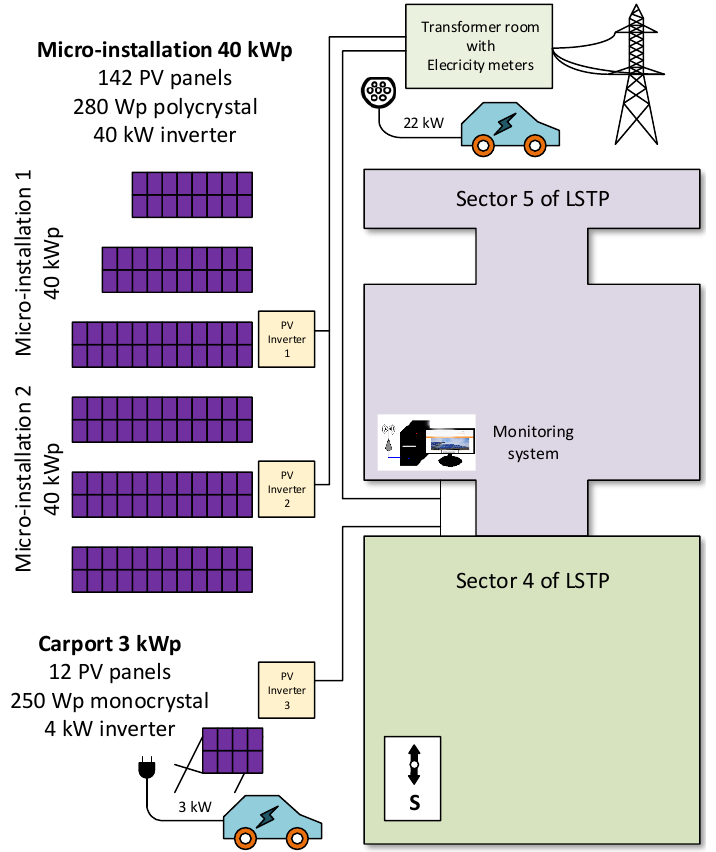
Figure 2. The general diagram of the PV system electrical connections to the LSTP building.